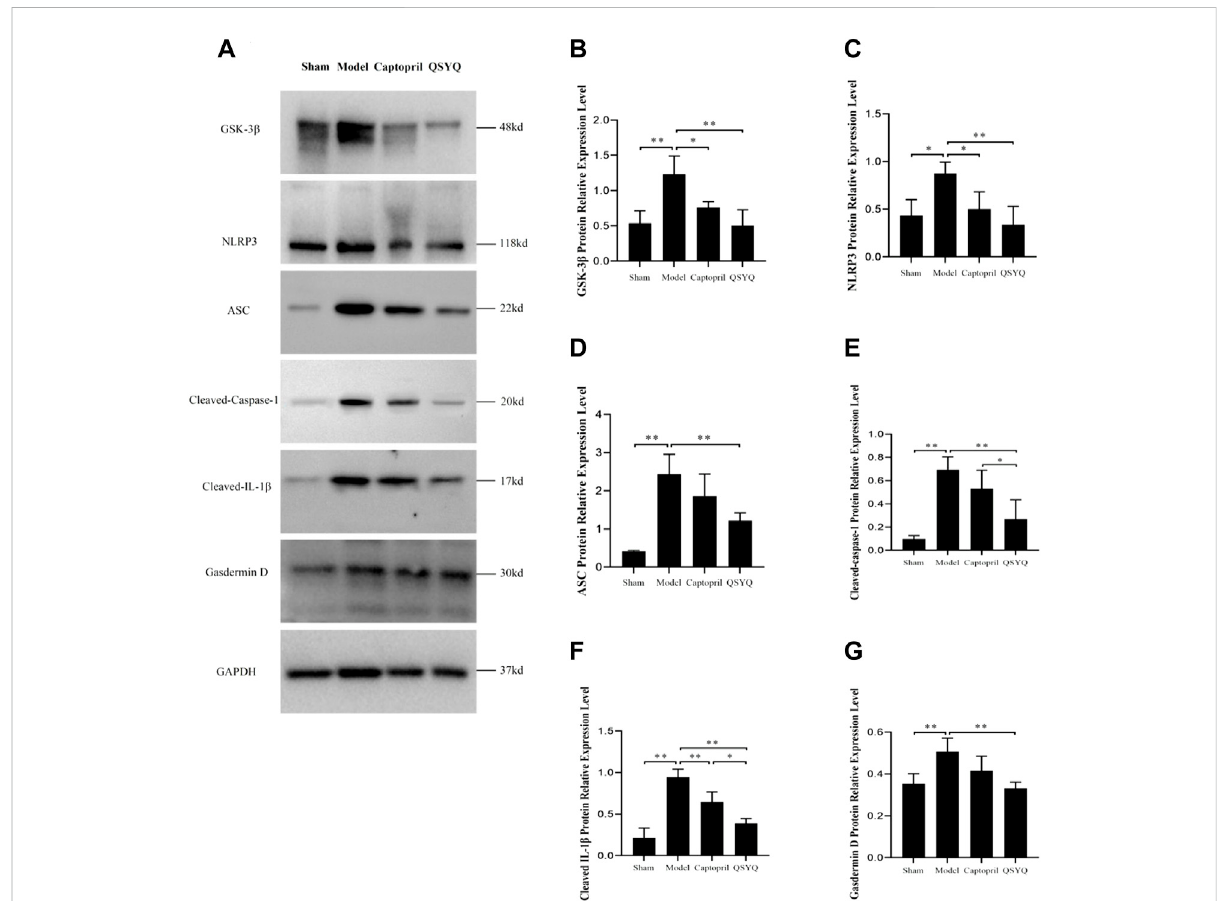
FIGURE 12 EffectofQSYQonNLRP3In fl ammasome. (A) :DetecttheeffectofQSYQonNLRP3In fl ammasomebyWesternblotineachgroup. (B – G)